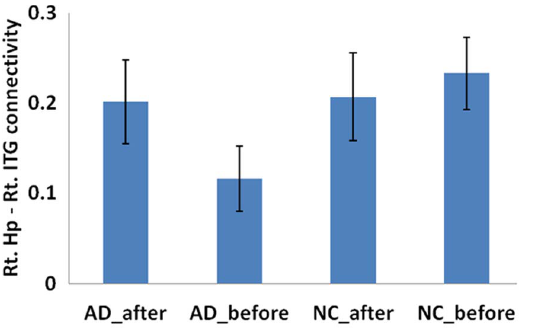
Figure 5. Comparison of connectivity of right hippocampus and right ITG between pre and post acupuncture among AD patients and controls. The acupuncture induced increased functional connectivity for the AD patients (t=1.61, p=0.056). There was no significant difference for healthy controls (t=0.403,p=0.345).